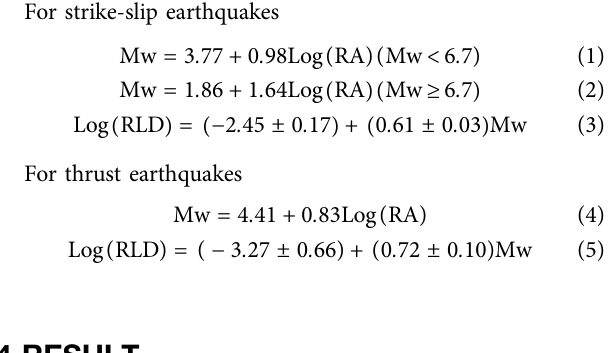
Frontiers in Earth Science |